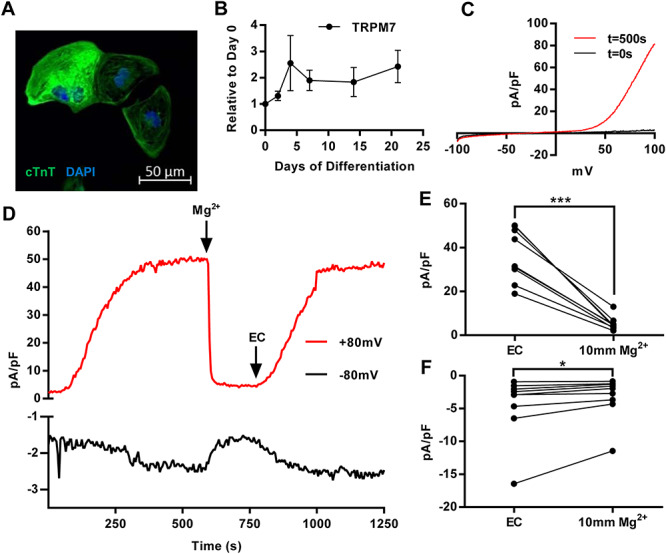
A TRPM7-like current can be found in 21-day-old hiPSC-derived cardiomyocytes. (A) Staining of hiPSC-CMs after 21 days of differentiation for cardiac troponin (cTnT) and DAPI. (B) qPCR analysis of TRPM7 expression levels over the course of hiPSC-CM differentiation. TRPM7 expression at each time point was normalized to GAPDH expression before being compared to TRPM7 expression in undifferentiated hiPSC cells. (C) A representative TRPM7 trace from whole-cell hiPSC-CMs. Initial current is shown (black) at initial current recordings before magnesium is removed from the bath, and a steady plateau is reached (red). (D) Time course recording of 22 day post-differentiation hiPSC-CM showing TRPM7 whole-cell current run-up and transient inhibition of 10 mm Mg2+ at +80 mV (red) and −80 mV (black). (E) Paired individual cell current measurements at +80 mV peak during extracellular solution perfusion, cells were then treated with 10 mm Mg2+ over several minutes until current plateaued. (F) Inward current recorded at −80 mV in the same cells analyzed in (D), after current stabilization and after 10 mm Mg2+ treatment. * = P < 0.05, *** = P < 0.001.